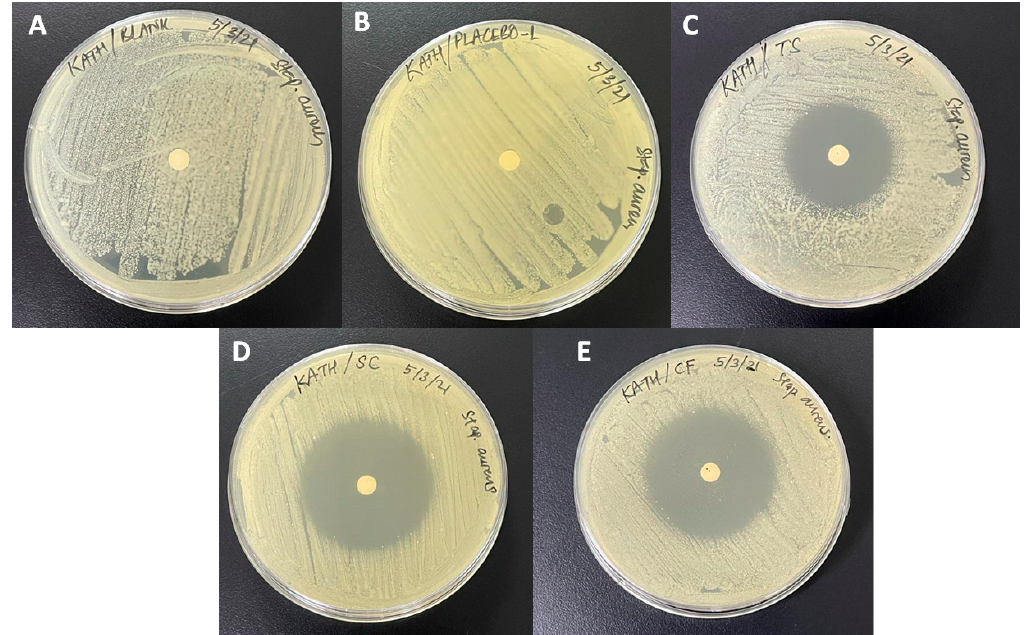
Figure 4. Antimicrobial test results by disc diffusion method (( A ) controlled; ( B ) optimized formulation F3 without drug; ( C ) marketed clindamycin topical solution (1% w / v ); ( D ) standard clindamycin solution (1% w / v ); ( E ) formulation F3 with clindamycin (1% w / v